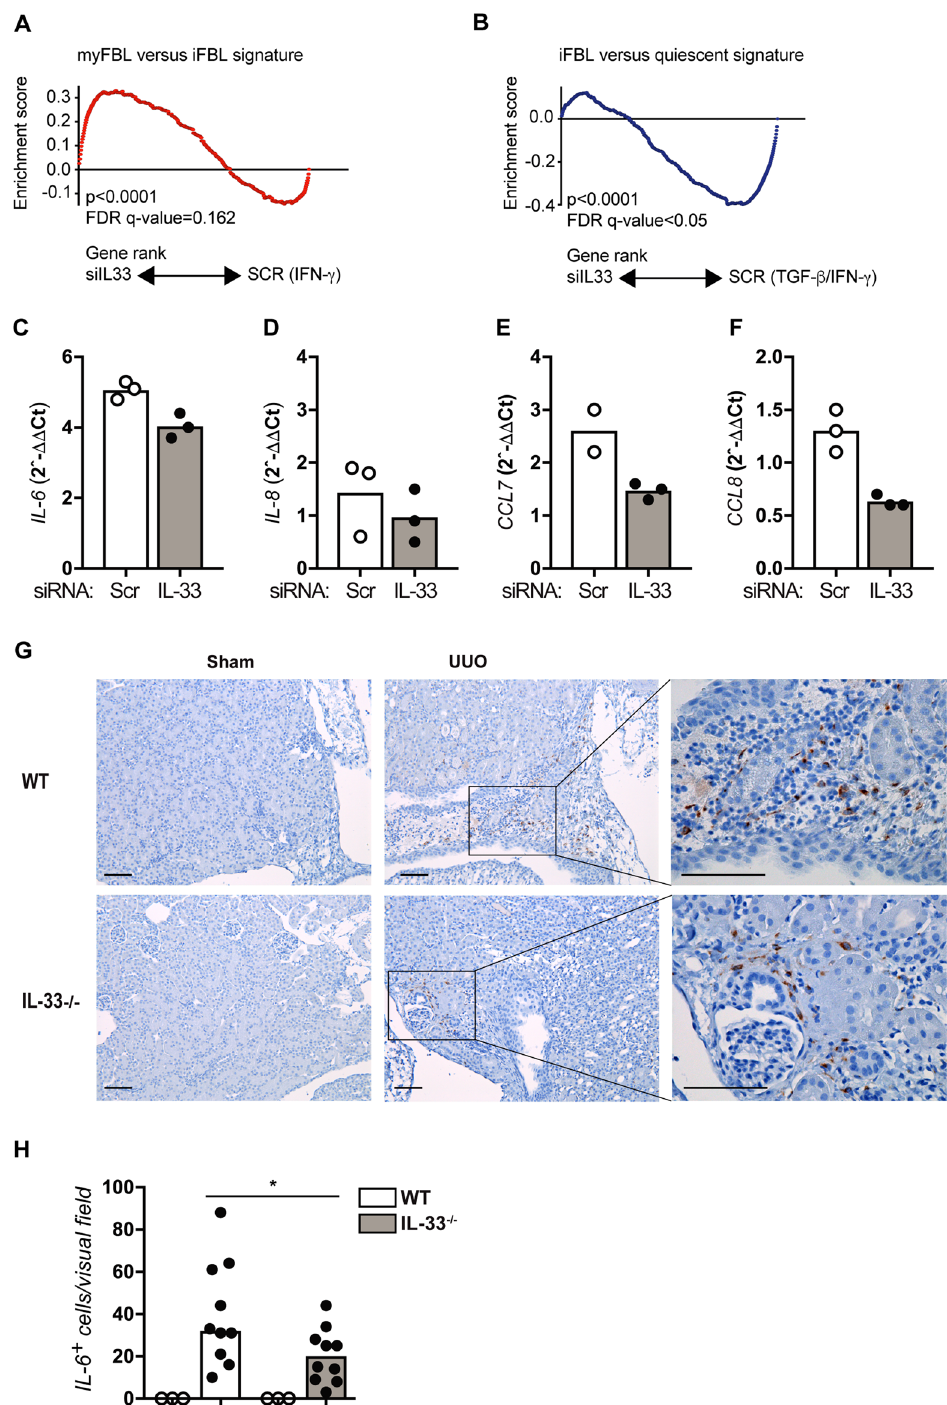
Figure 6. Depletion of IL-33 skews fibroblasts towards a myofibroblastic phenotype. ( A , B ) Gene set enrichment analysis showed that cells treated with IL-33-specific siRNA were positively enriched for a myofibroblast (myFBL) versus inflammatory fibroblast (iFBL) signature and negatively enriched for an inflammatory versus quiescent fibroblast signature. ( C – F ) Transcription of IL6 ( C ), IL8 ( D ) , CCL7 ( E ) and CCL8 ( F ) in human fibroblasts treated with IL33-specific or scrambled siRNA was measured by qRT-PCR. Each data point shows mean values of technical triplicates from independent experiments. ( G ) Representative photomicrographs of kidney sections harvested 4 days after sham or UUO surgery from WT and IL-33 −/− mice and immunostained for IL-6 (brown signal). Scale bars = 100 μm. ( H ) Blinded quantification of signal enumerating the average number of positive cells per high-power visual field. Individual data points show the average number of positive cells in one mouse, counting 3 high power fields in areas of highest density. *p <